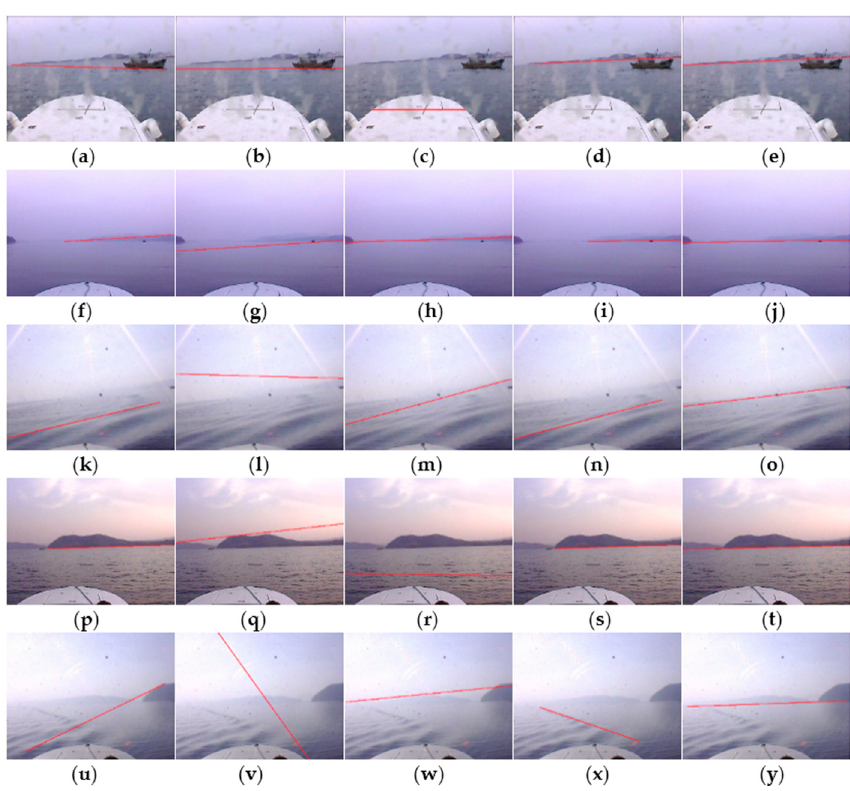
Figure 11. Line feature detection results of optical images: ( a – c ) are results of the Hough transform method; ( d – f ) are results of Radon transform method; ( g – i ) are results of the proposed method.